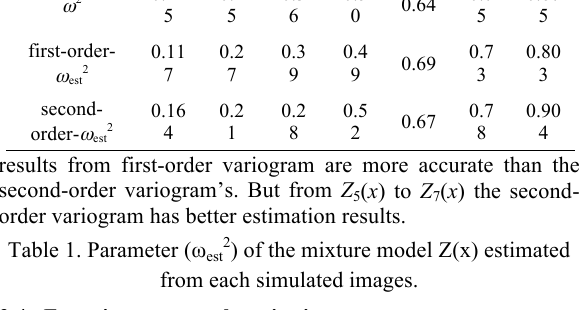
Table 1. Parameter ( ω est2 ) of the mixture model Z(x) estimated from each simulated images.